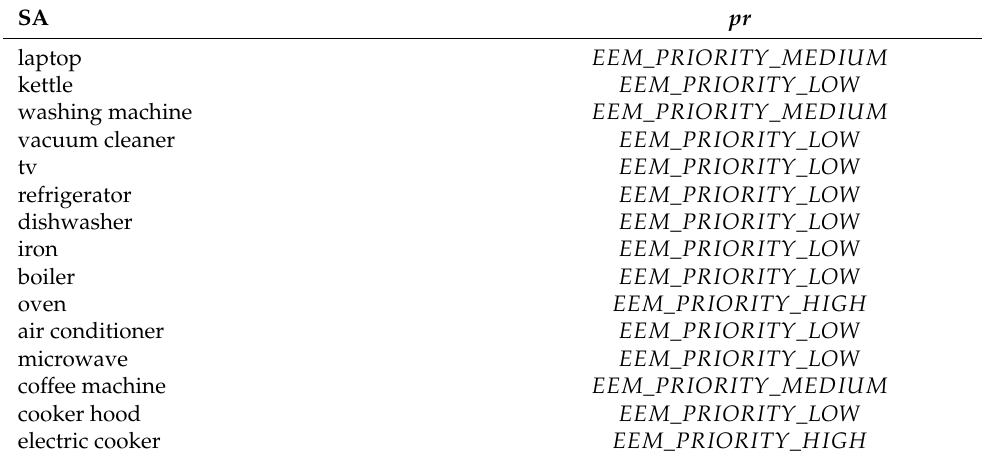
Table 1. List of SAs and their assigned pr